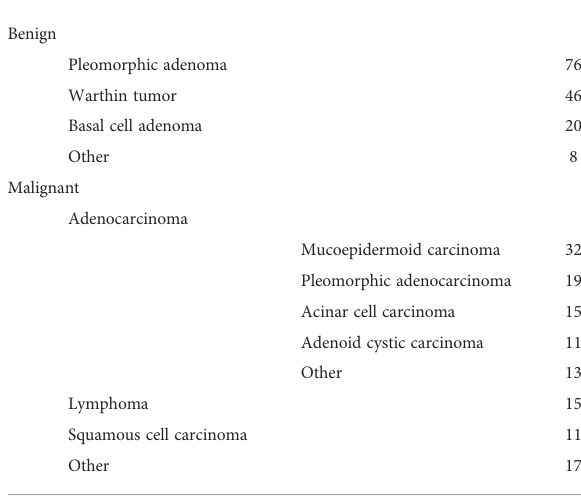
TABLE 1 The pathological classi fi cation of the 283 tumors